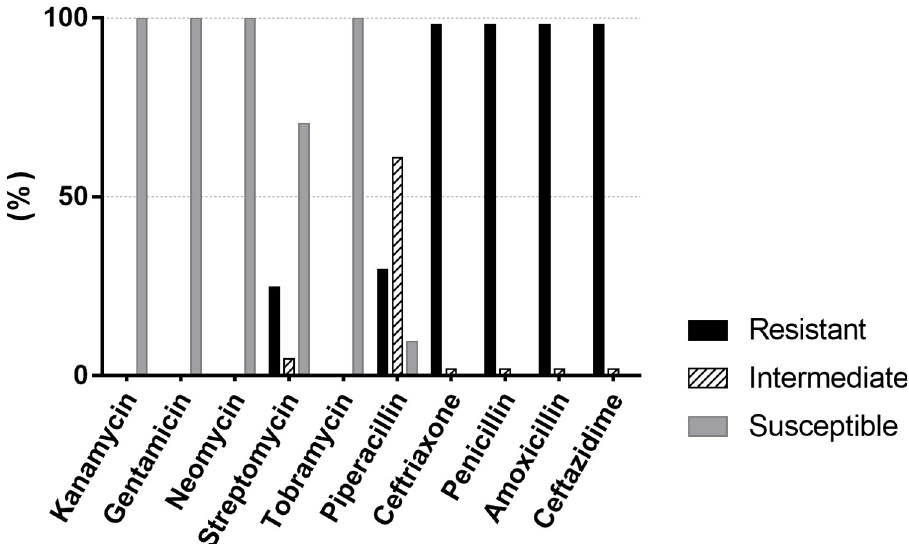
Fig 2. Antibiotic susceptibility profiles of 105 isolates. The first five drugs on the x-axis are aminoglycosides and the last five are β -lactams.